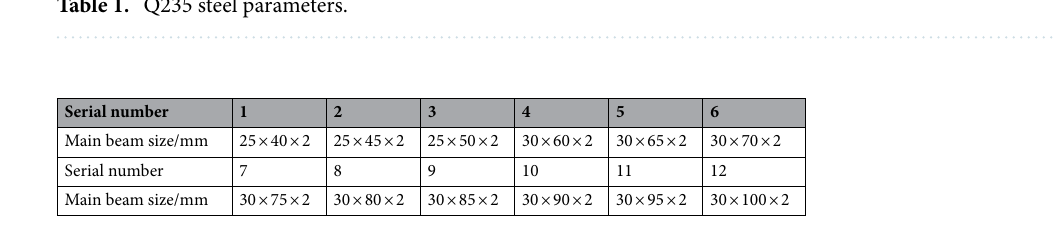
Table 2. Characteristics of the greenhouse frame materials.